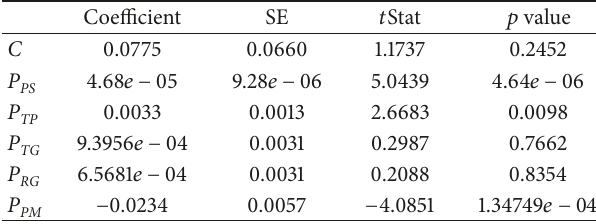
Table 4: Linear regression model of end-to-end delay.